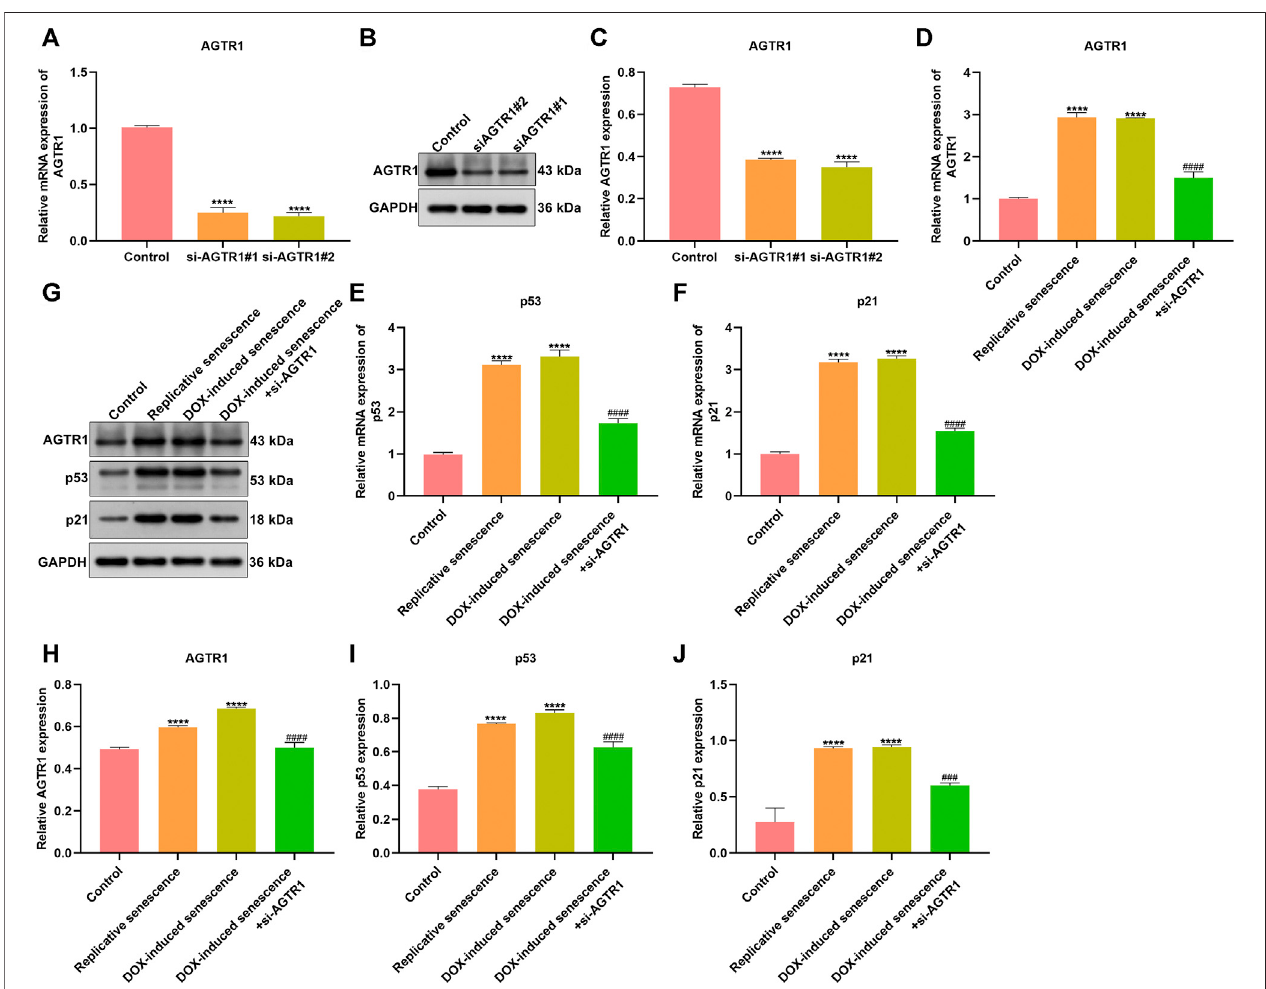
FIGURE 9 | Silencing AGTR1 ameliorates stromal cell senescence. (A – C) RT-qPCR and Western blotting detected AGTR1 expression in HUVECs transfected by siAGTR1. (D – F) RT-qPCR and (G – J) Western blotting were utilized for examining AGTR1, p53, and p21 expression in four groups: control, replicative senescence, DOX-induced senescence, and DOX-induced senescence + siAGTR1 groups. Compared with control, **** p < .0001. Compared with DOX-induced senescence, ### p < .001; #### p <